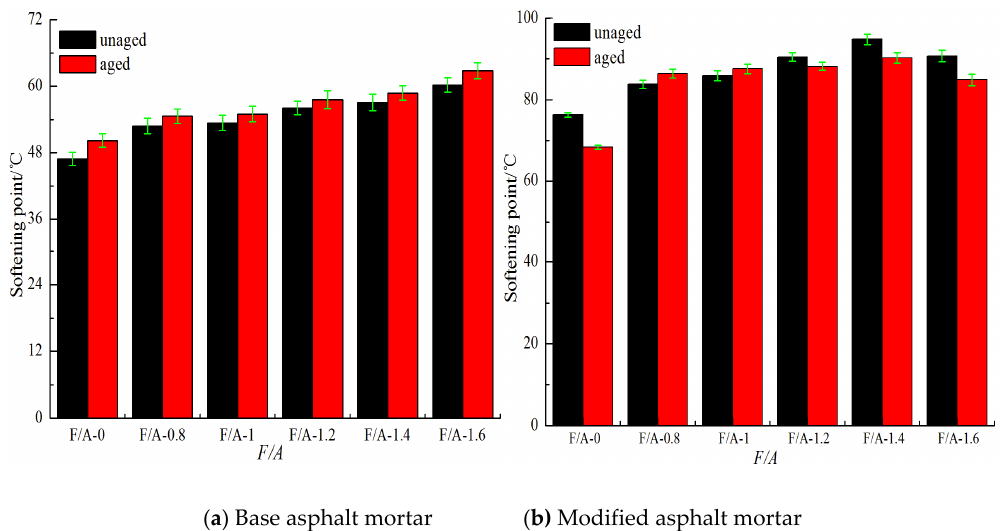
Figure 3. Softening point of asphalt mortar before and after UV aging.